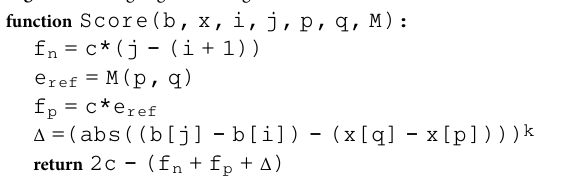
Algorithm 1 SegAligner scoring